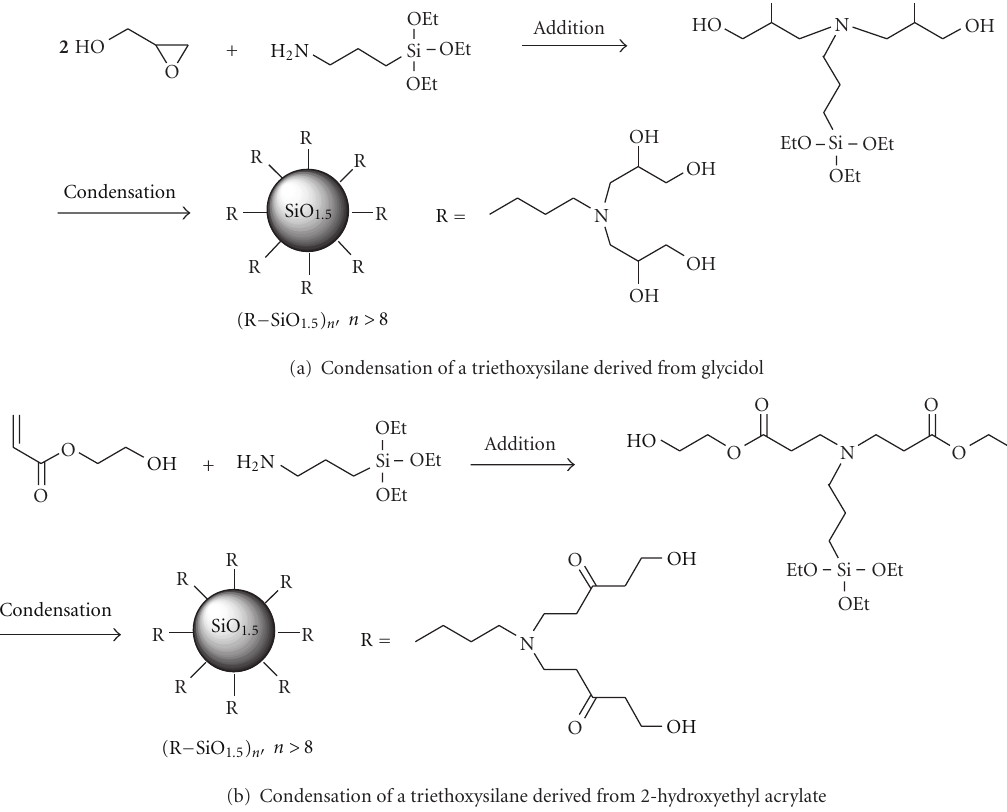
Figure 4: Synthesis of water-soluble silsesquioxane-based nanoparticles by hydrolytic condensation of hydroxyl-functionalized triethoxysi-